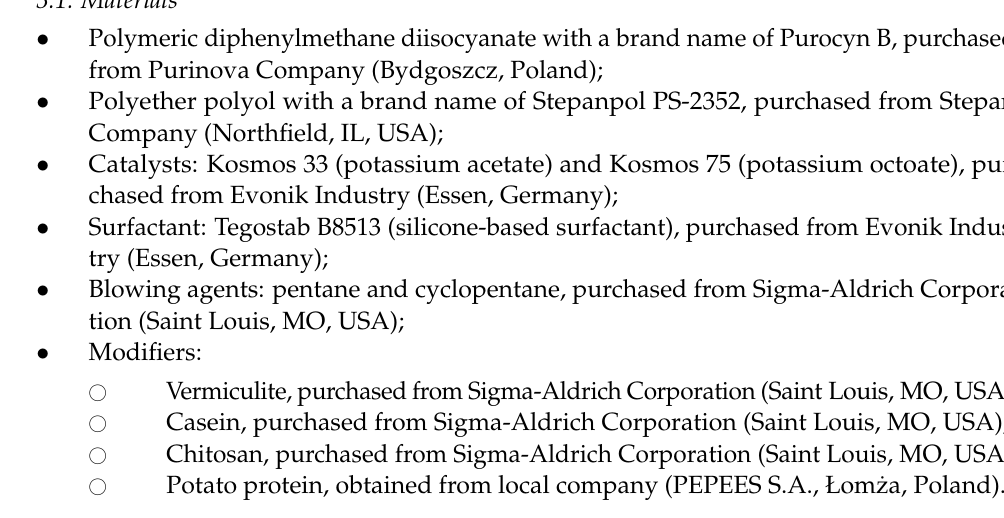
Figure 9. Images of the contact angles measured for ( a ) PU_0, ( b ) PU_V, ( c ) PU-VC, ( d ) PU-VCH, and ( e )